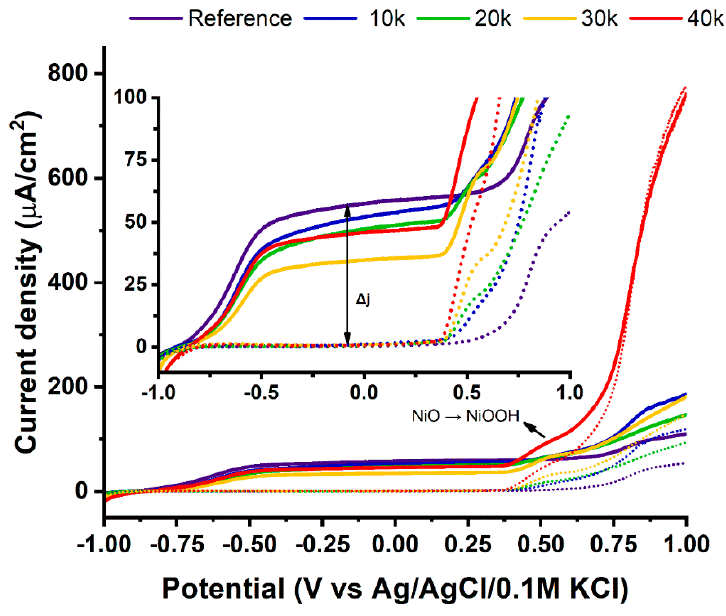
Figure 6. Linear voltammograms of the modified titania nanotubes investigated in the dark (dotted line) and under simulated AM 1.5 light (solid line).